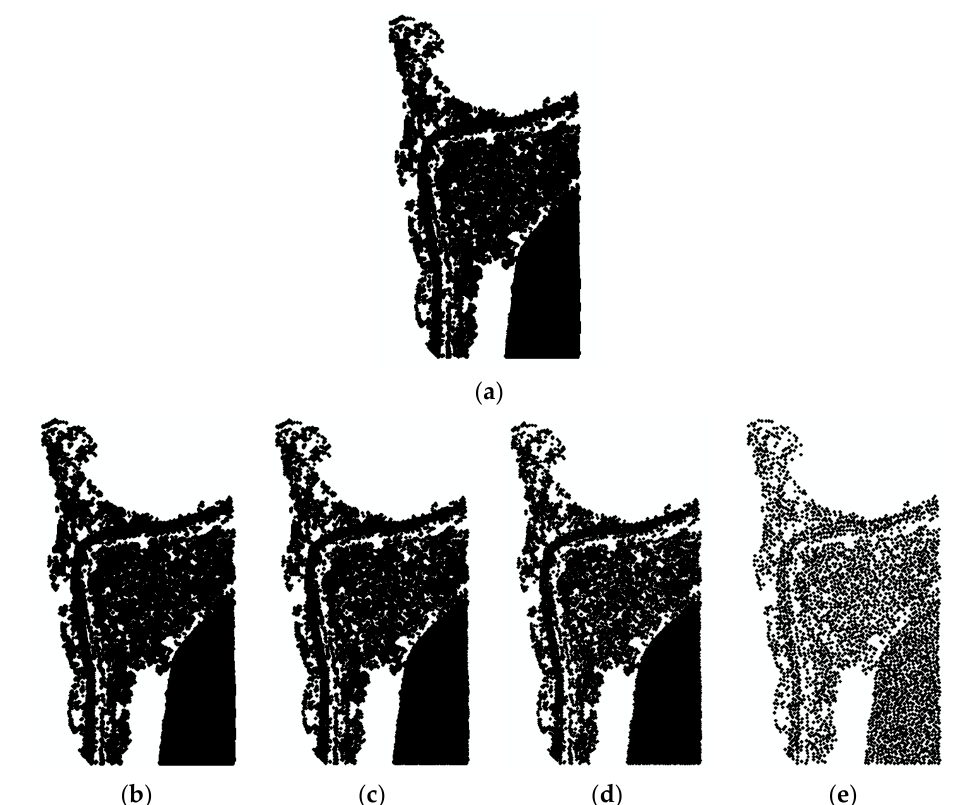
Figure 6. Example of reduced sets of UAS data: ( a ) raw UAS data, ( b ) reduced datasets with R = 0.2 m, ( c ) reduced datasets with R = 1 m, ( d ) reduced datasets with R = 2 m, ( e ) reduced datasets with R = 4 m.